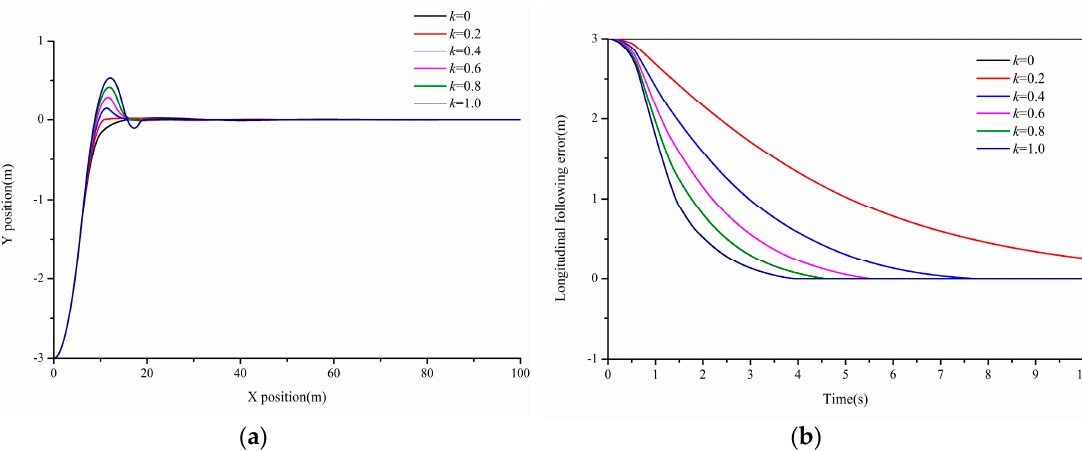
Figure 5. Particle motion under the different values of k : ( a ) The path of particle model under the different values of k ; and, ( b ) The following error of particle model under the different values of k .